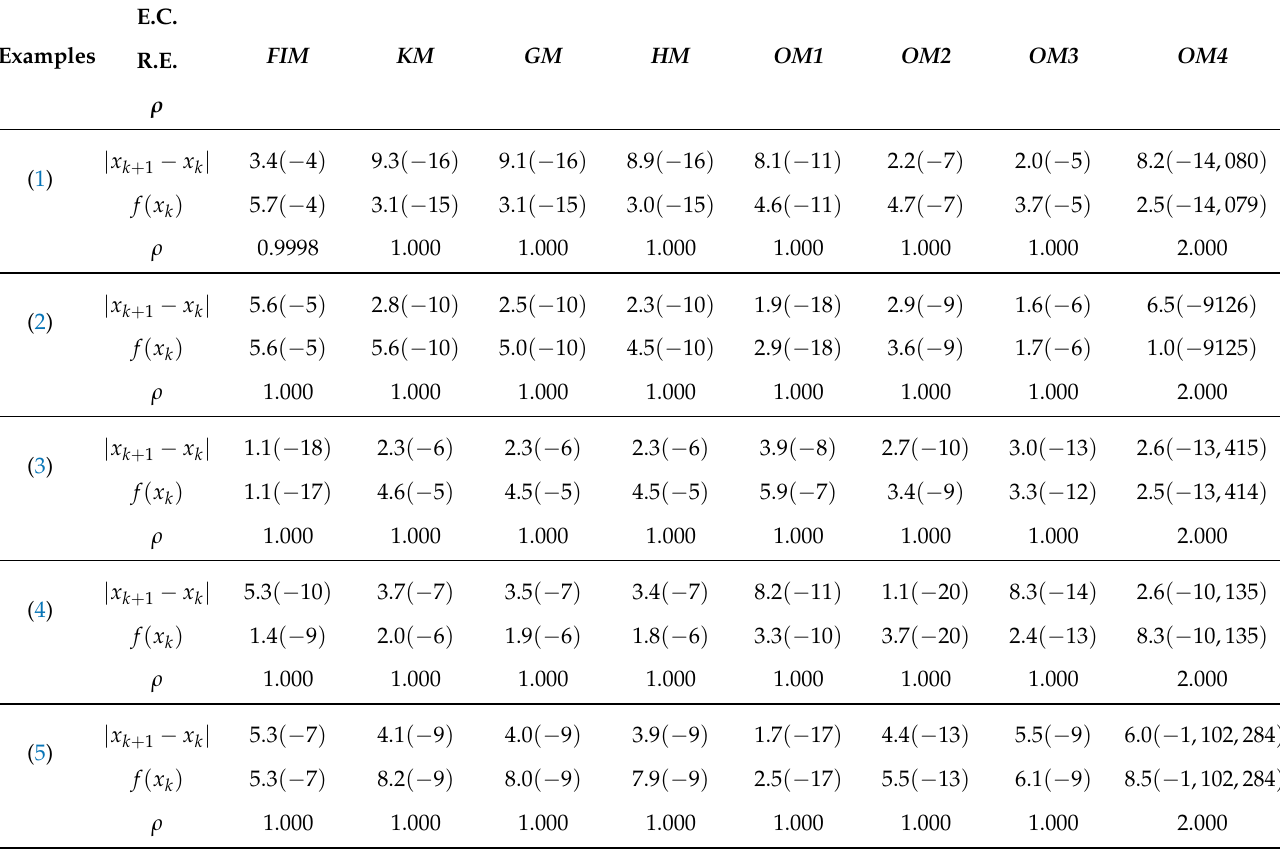
Table 2. Comparison of different fixed point methods on Examples (1)–(5) with k =